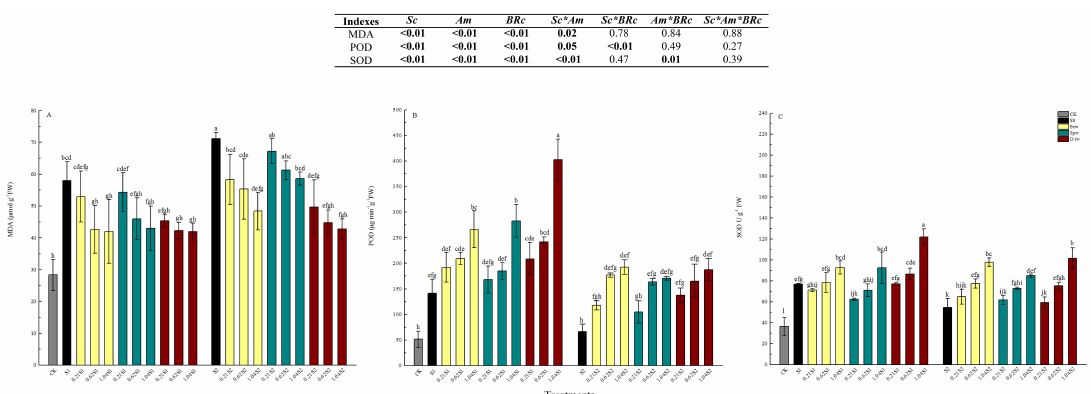
Figure 5. Effects of exogenous 24-epiBL on ( A ) malondialdehyde (MDA), ( B ) peroxidase (POD), and ( C ) superoxide dismutase (SOD) of leaves of black locust seedlings at 100 (SS-S1) or 200 (SS-S2) mM NaCl. Other details as in Figure